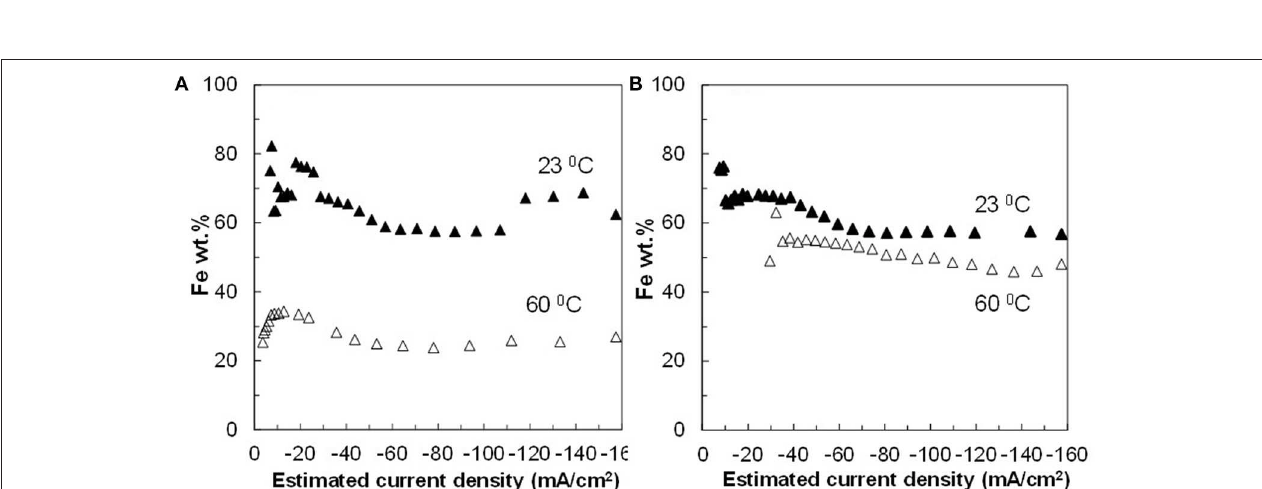
Frontiers in Chemistry |